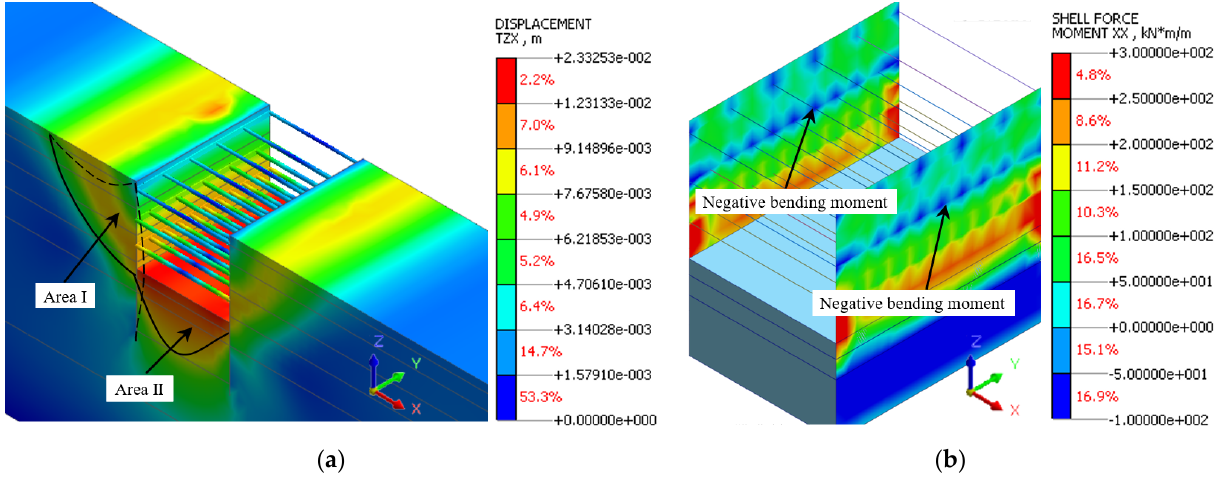
Figure 7. Diagram of the deformation diagram of the foundation pit excavation and bending mo- ment diagram of the support structure. ( a ) Deformation of foundation pit excavation; ( b ) bending moment of thee support